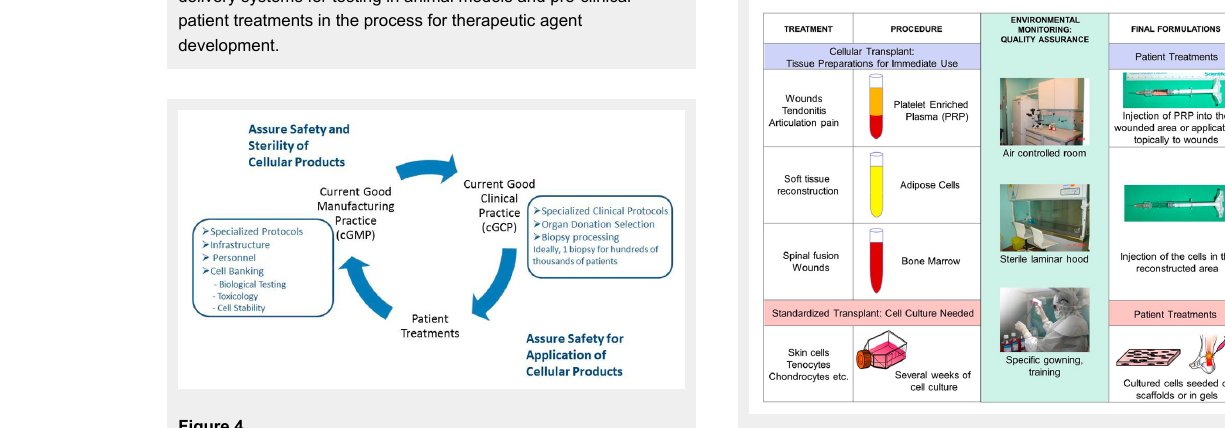
Good Clinical Practice and Good Manufacturing Practice associated with cellular